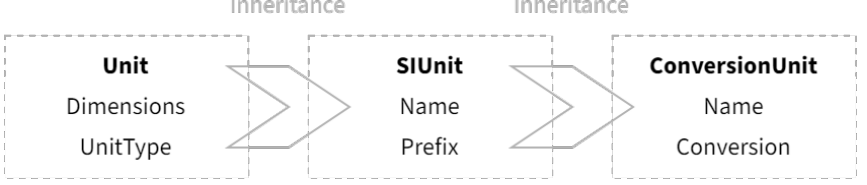
Figure 3. Illustration of the type system.